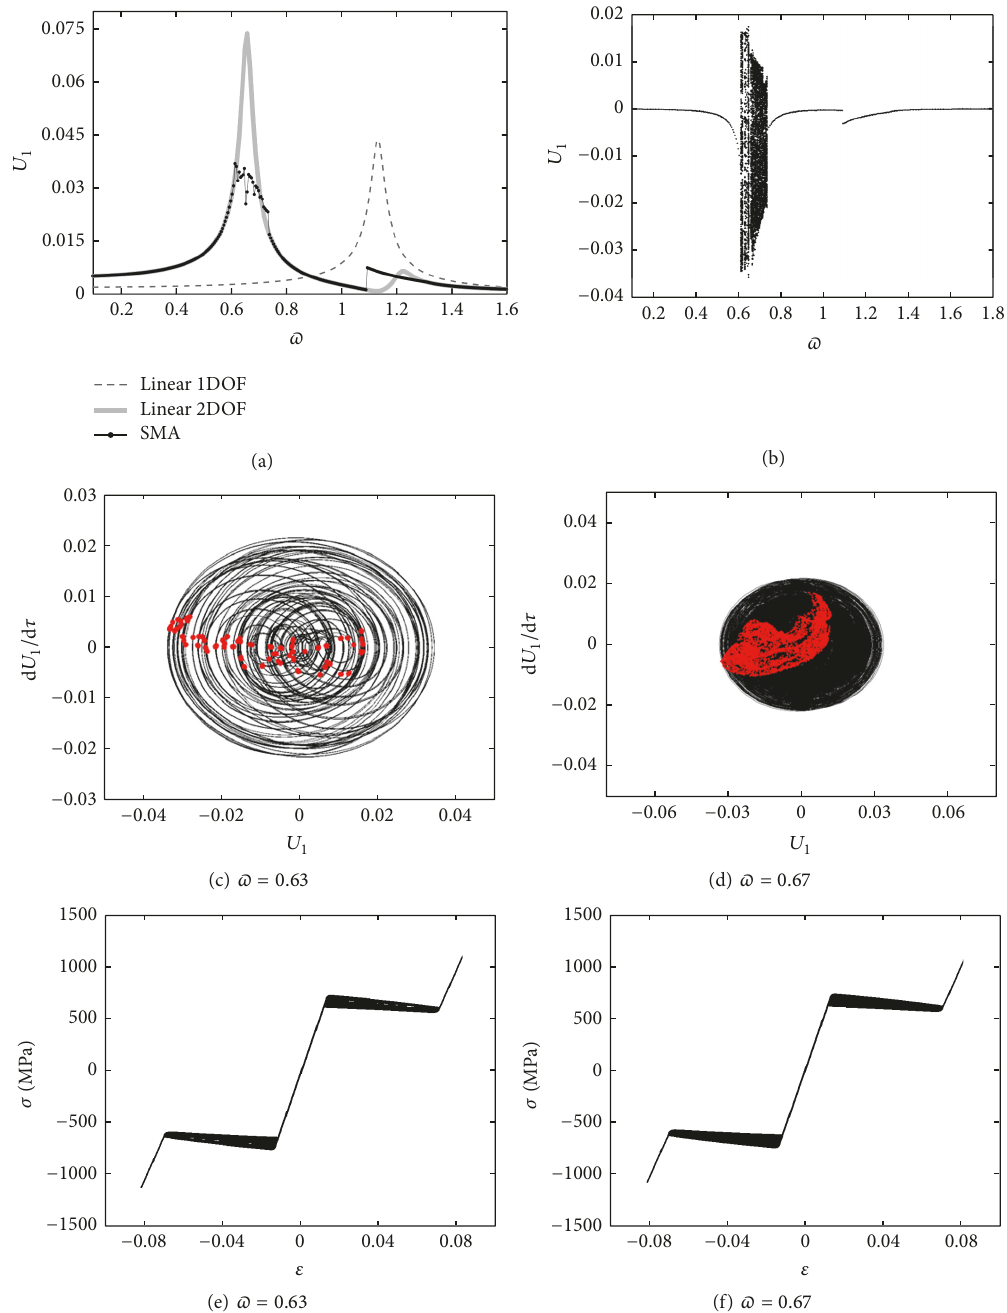
Figure 8: Primary system response with 𝛿 = 0.0025 and 𝛾 𝑚 = 0.1 in up-sweep test: (a) maximum amplitude; (b) bifurcation diagram; (c-d) phase space with Poincar´e section; (e-f) stress-strain